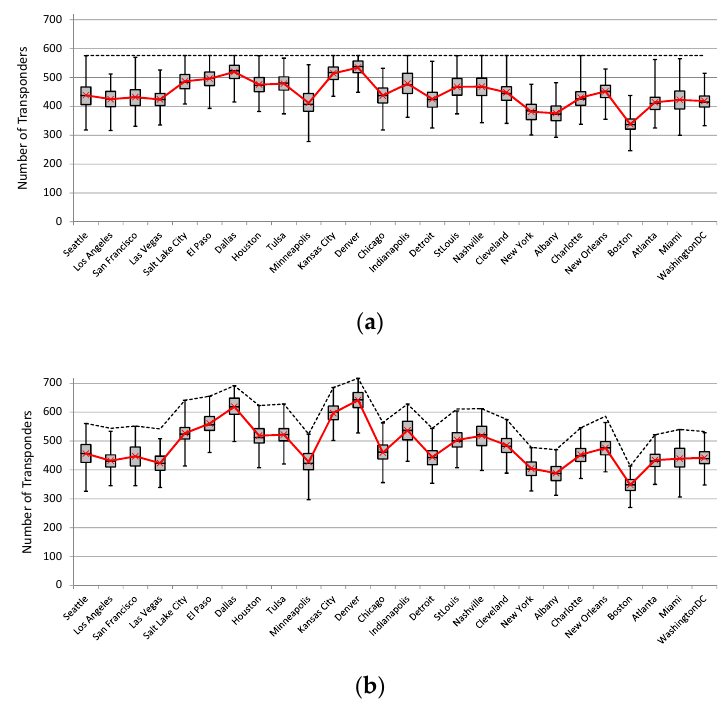
Figure 16. Box graph with placement of transponders given by: ( a ) UNI and ( b ) SAUR algorithms, for the US26 network, TP C, and 15,000 transponders. The dotted line shows the number of transponders in each node according to a particular algorithm. The red line represents the average observed values of transponder usage, while the boxes show data through their quartiles.